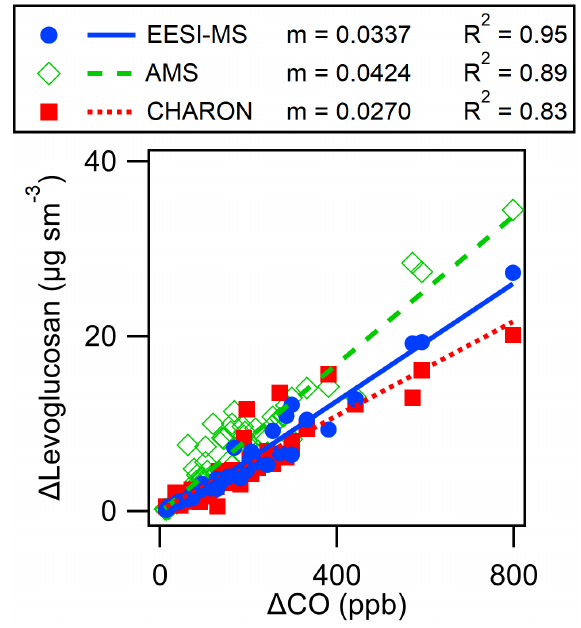
Figure 8. Comparison of 1min EESI-MS and CHARON PTR- MS excess levoglucosan and AMS excess levoglucosan-equivalent vs. excess CO for a single FIREX-AQ flight. Excess levoglucosan or CO is determined by subtracting the background concentration from the in-plume average